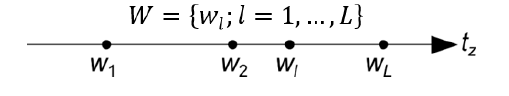
Figure 1. Discrete accident process (own elaboration).